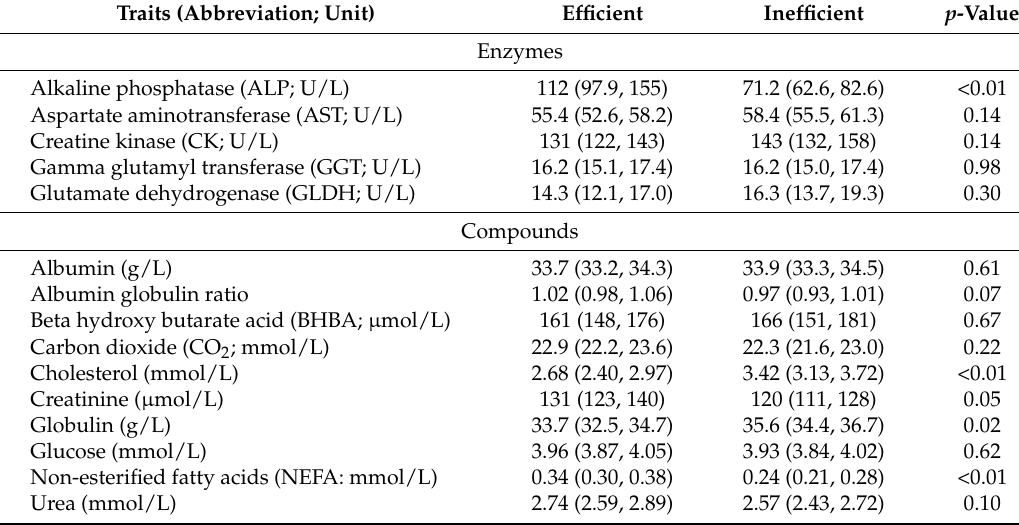
Table 5. Blood plasma analytes least square means (confidence interval) across the performance evaluation test in pregnant heifers by feed efficiency group repeatedly